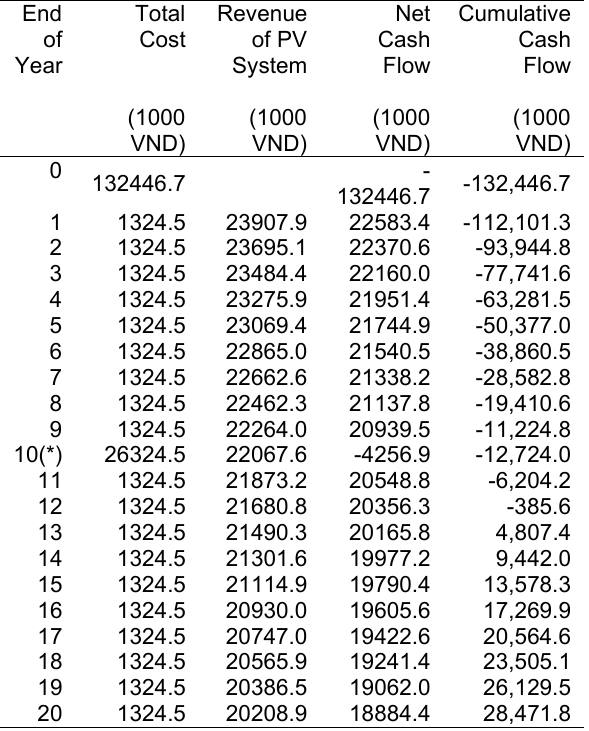
Figure 11. Cumulative Cash Flow at discount rate of